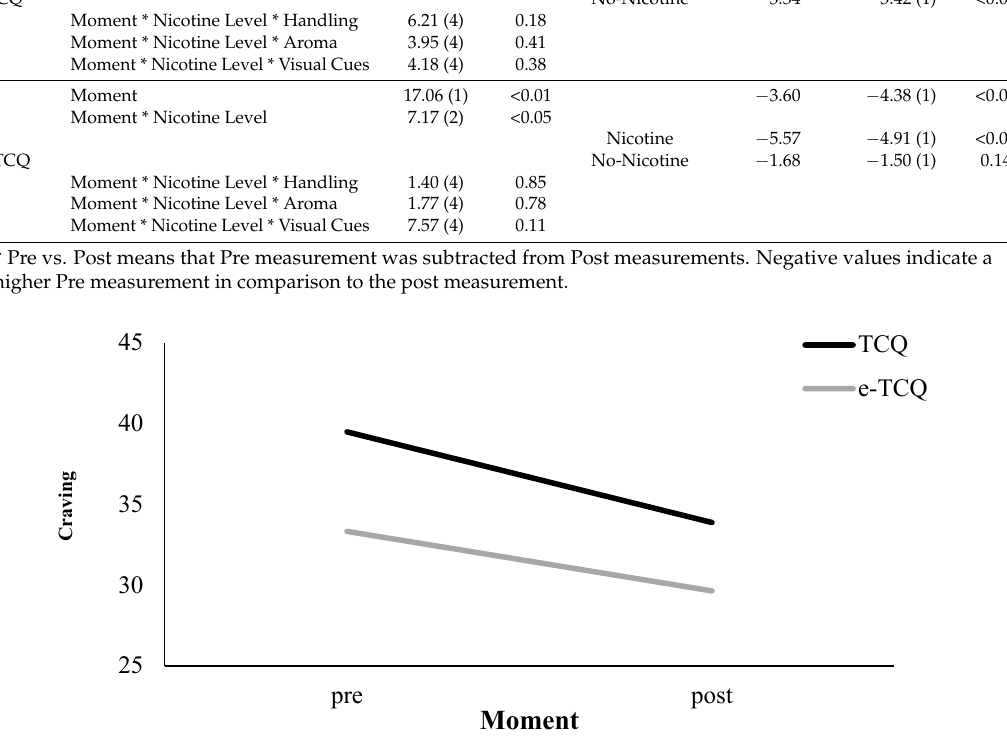
Figure 4. TCQ craving measurements pre and post vaping: tobacco cigarette craving (TCQ) and e-cig craving (e-TCQ).